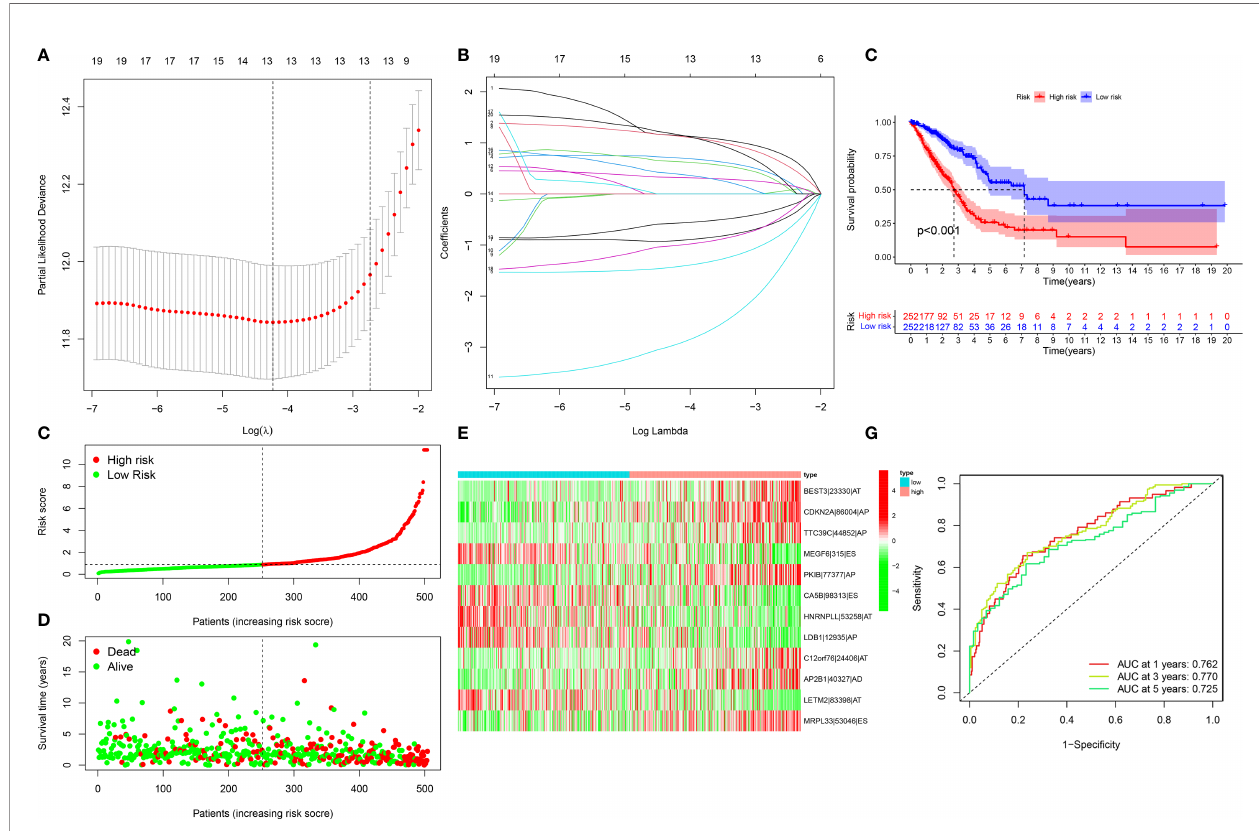
FIGURE 2 | Development of a reliable prognostic model for LUAD patients. (A) The distribution of partial likelihood deviance corresponding to l -logarithm value. (B) LASSO coef fi cient pro fi ling of OS-relevant AS events. The lines stood for OS-relevant AS events and candidates AS events were chosen utilizing ten-fold cross- veri fi cation with minimum criteria. (C) The distribution of risk score across LUAD patients. Red dots meant high-risk patients while green dots meant low-risk patients. (D) Scatter plots depicted distribution of LUAD patients ’ survival time andstatus. Red dots denoted patients whowere dead,whereas green dots denoted patients who were alive. (E) Heatmap displayed the distribution of PSI values for the established prognosticmodel. (F) Kaplan – Meier survival curves ofhigh- and low-riskLUAD patients. (G) ROC curves at 1, 3, and 5 yearsofthe prognostic model for LUAD